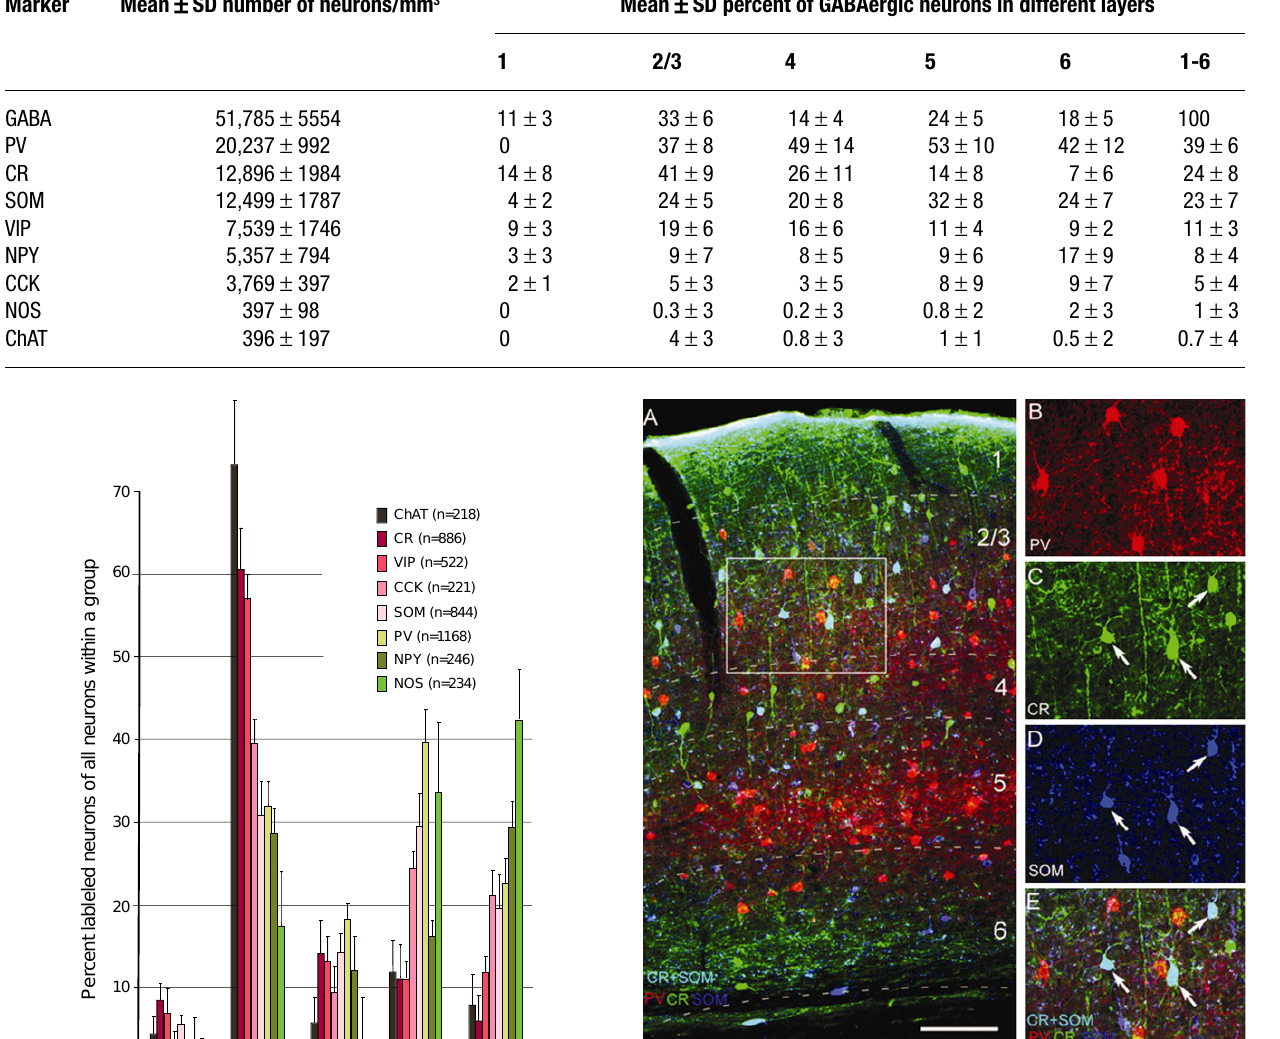
Table 2. Overall density and percentages of GABAergic neurons expressing PV, CR, SOM, VIP, NPY, CCK, NOS and ChAT in different layers of adult mouse primary visual cortex, determined in single labeling experiments. The mean number of cells/mm 3 were determined using systematic random sampling with the optical disector probe. To estimate the percentage of PV, CR, SOM, VIP, NPY, CCK, NOS and ChAT neurons in the population of GABAergic neurons, we compared the number of each cell type/mm 3 with the number of GABAergic neurons/mm 3 .